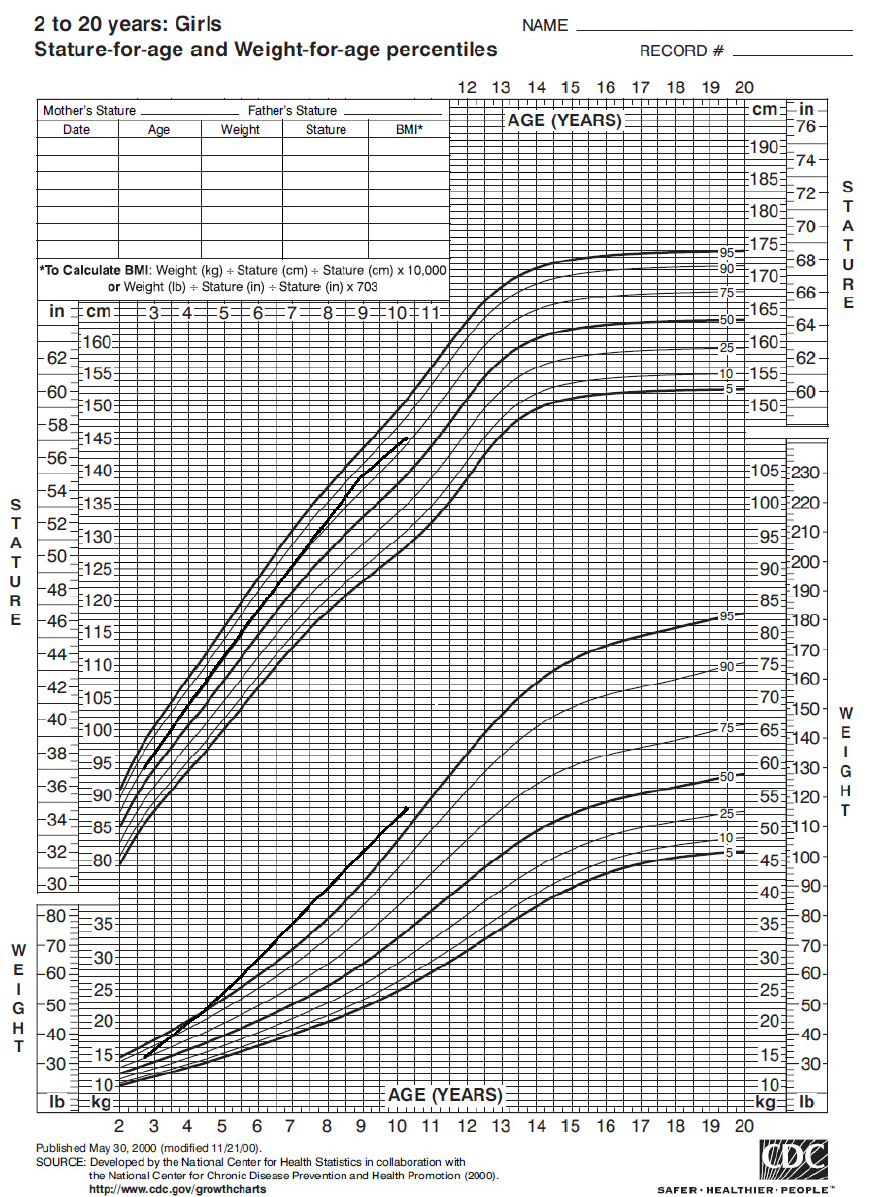
Figure 1. Statural–ponderal growth of our case from 2 to 10 years of age, according to CDC 2000 growth chart. Therefore, she started nutrition care visits; she showed mild hyperphagia, short satiation and low daily aerobic physical activity. In the past year she began a hypocaloric balanced diet and her BMI did not increase further. However, her parents did not give consent to obesity genetic tests.